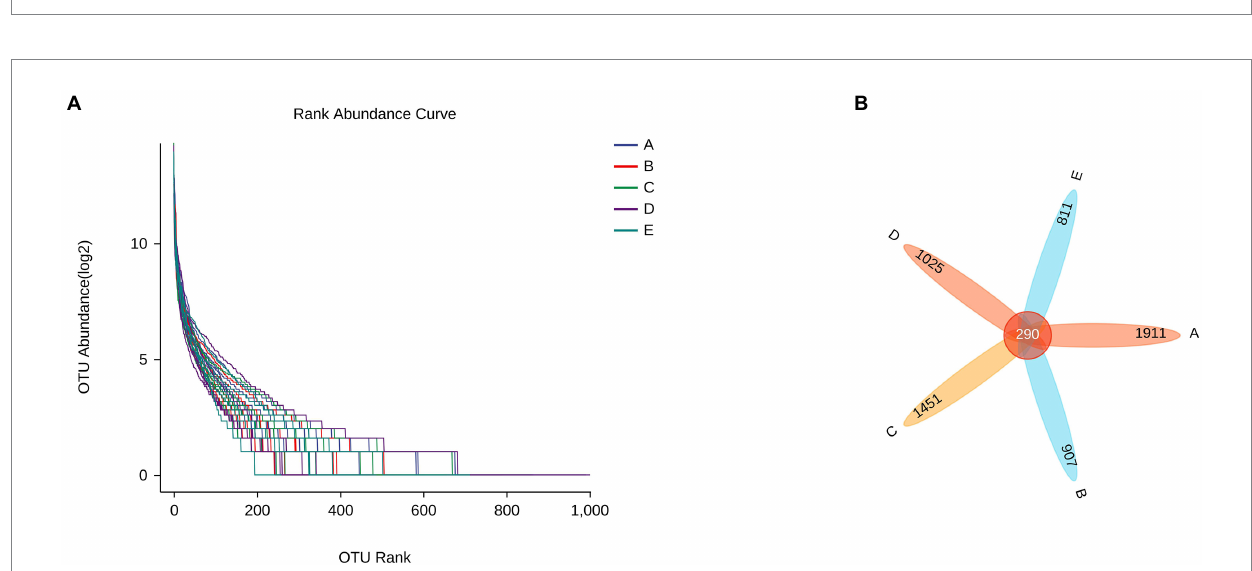
FIGURE 7 The effect of CSPCM on Alpha index in mice samples. (A) The effect of CSPCM on Chao1 index. (B) The effect of CSPCM on Coverage index. (C) The effect of CSPCM on Species. (D) The effect of CSPCM on Pelou-e index. (E) The effect of CSPCM on Shannon index. (F) The effect of CSPCM on Simpson index.